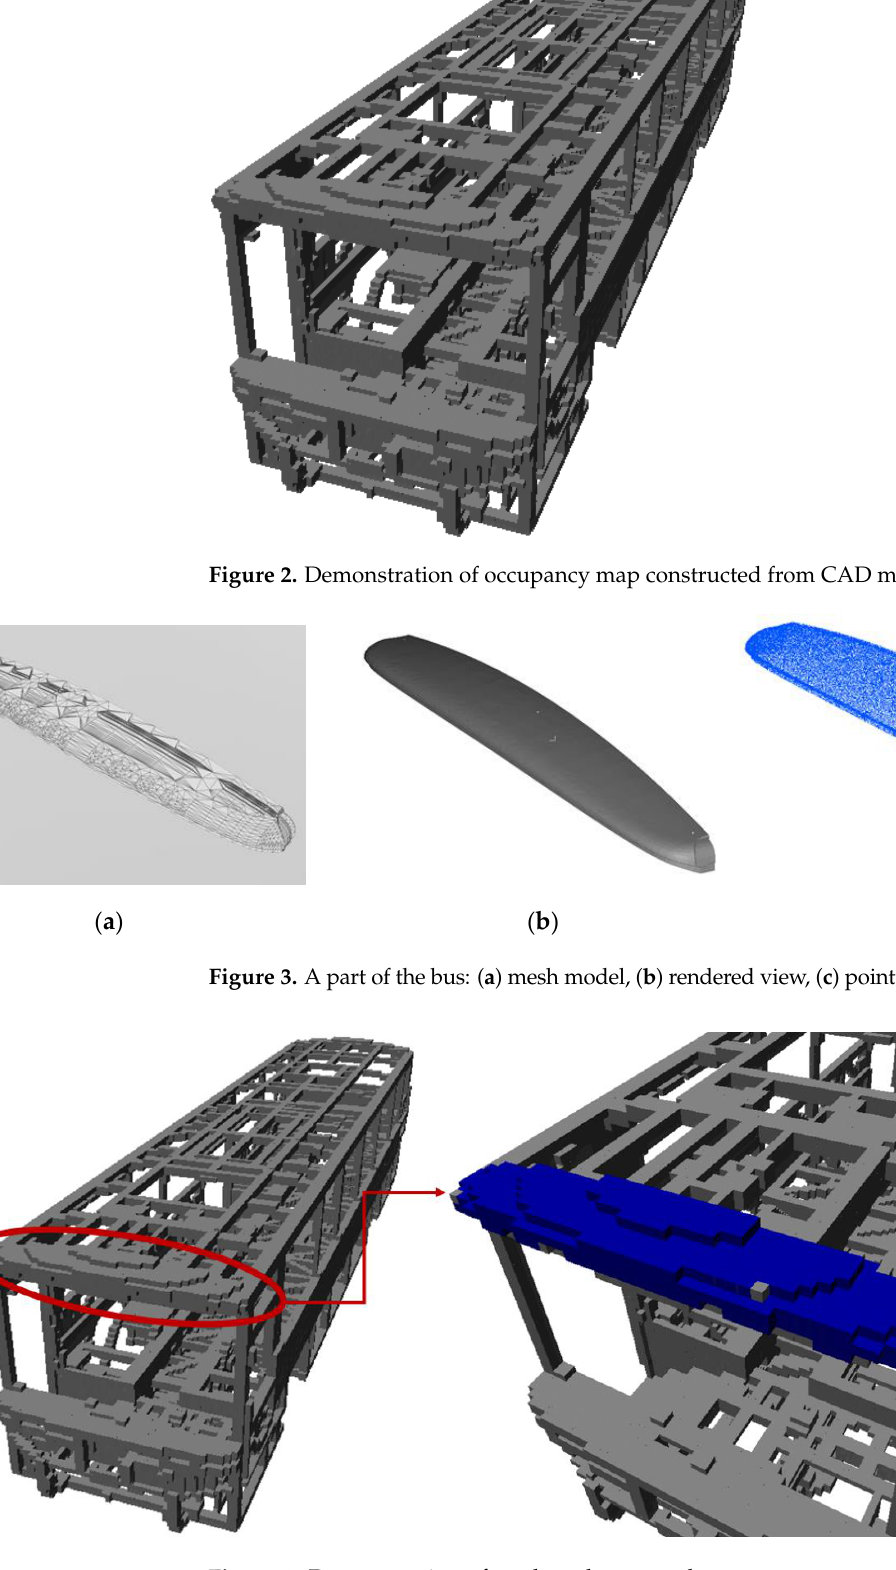
Figure 4. Demonstration of a selected part on the occupancy map of the bus (the selected part is indicated in blue on the occupancy map).